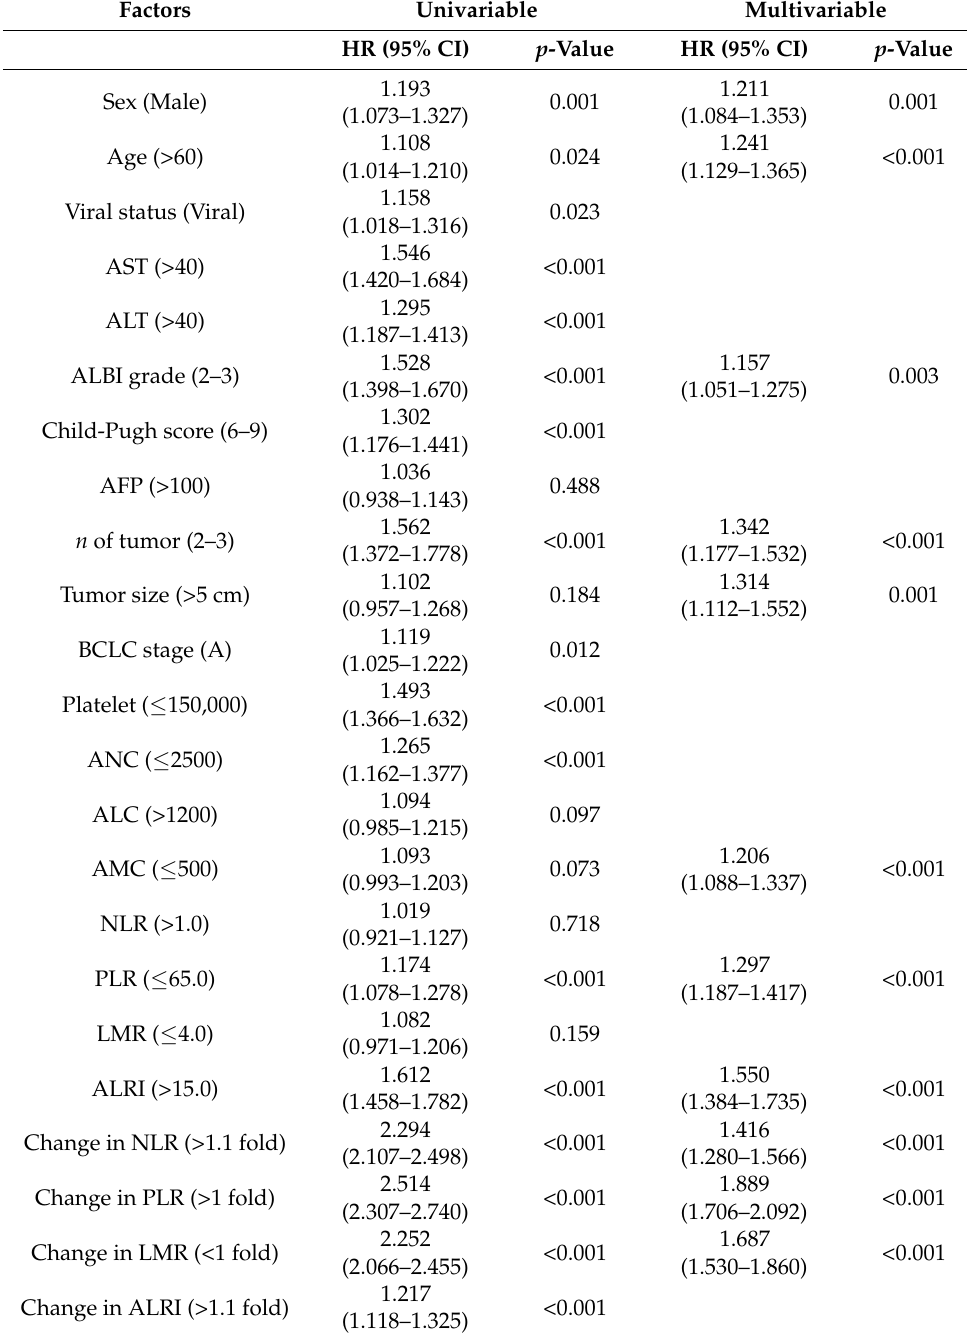
Table 2. Univariable and multivariable Cox regression analysis of intrahepatic recurrence-free